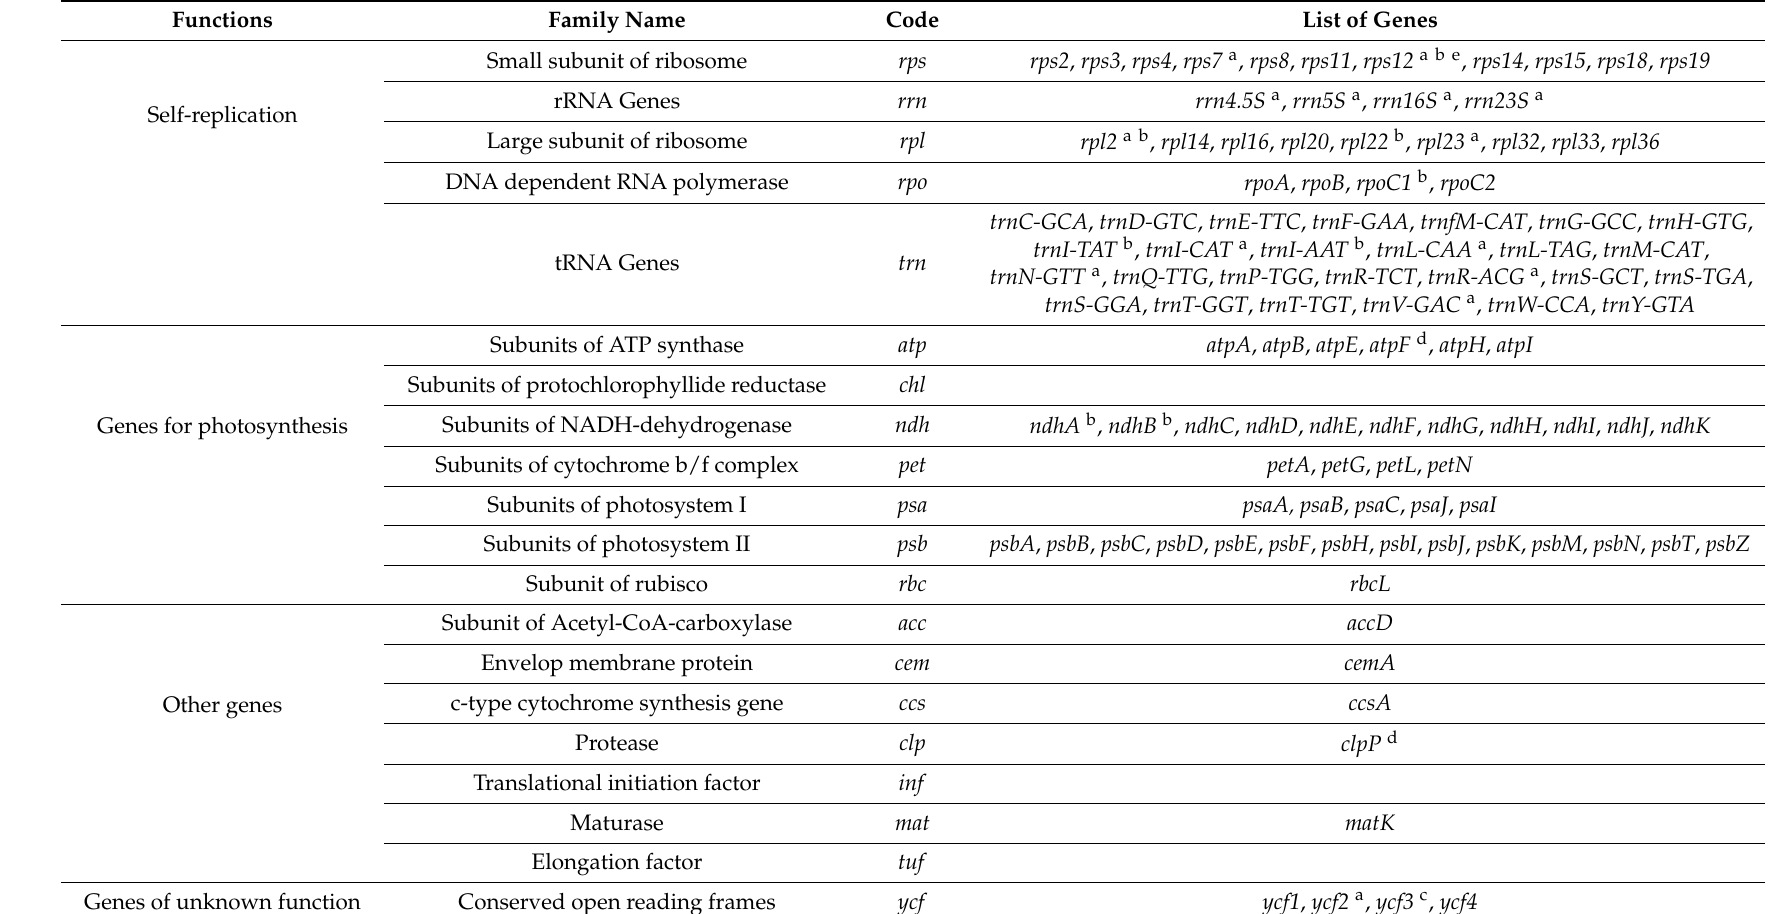
Table 1. Genes of the cp genome of P. hopeiensis